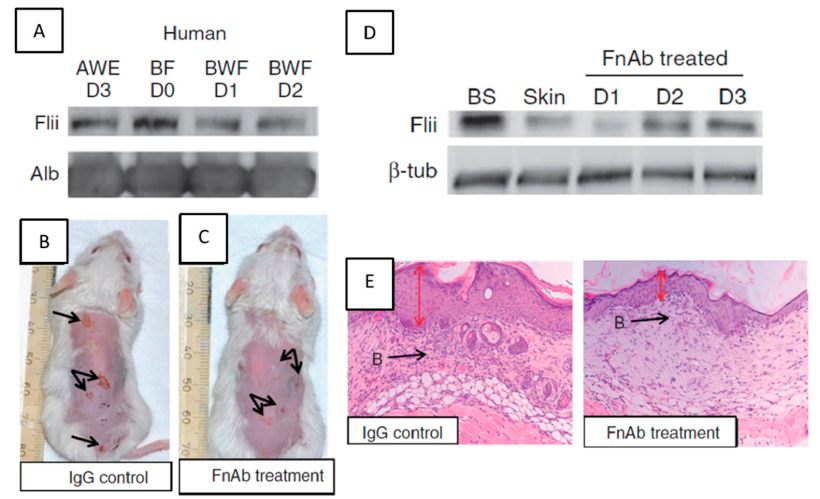
Figure 5. Effect of FnAb therapy on healing of EBA blisters. ( A ) Flii is present in human blister